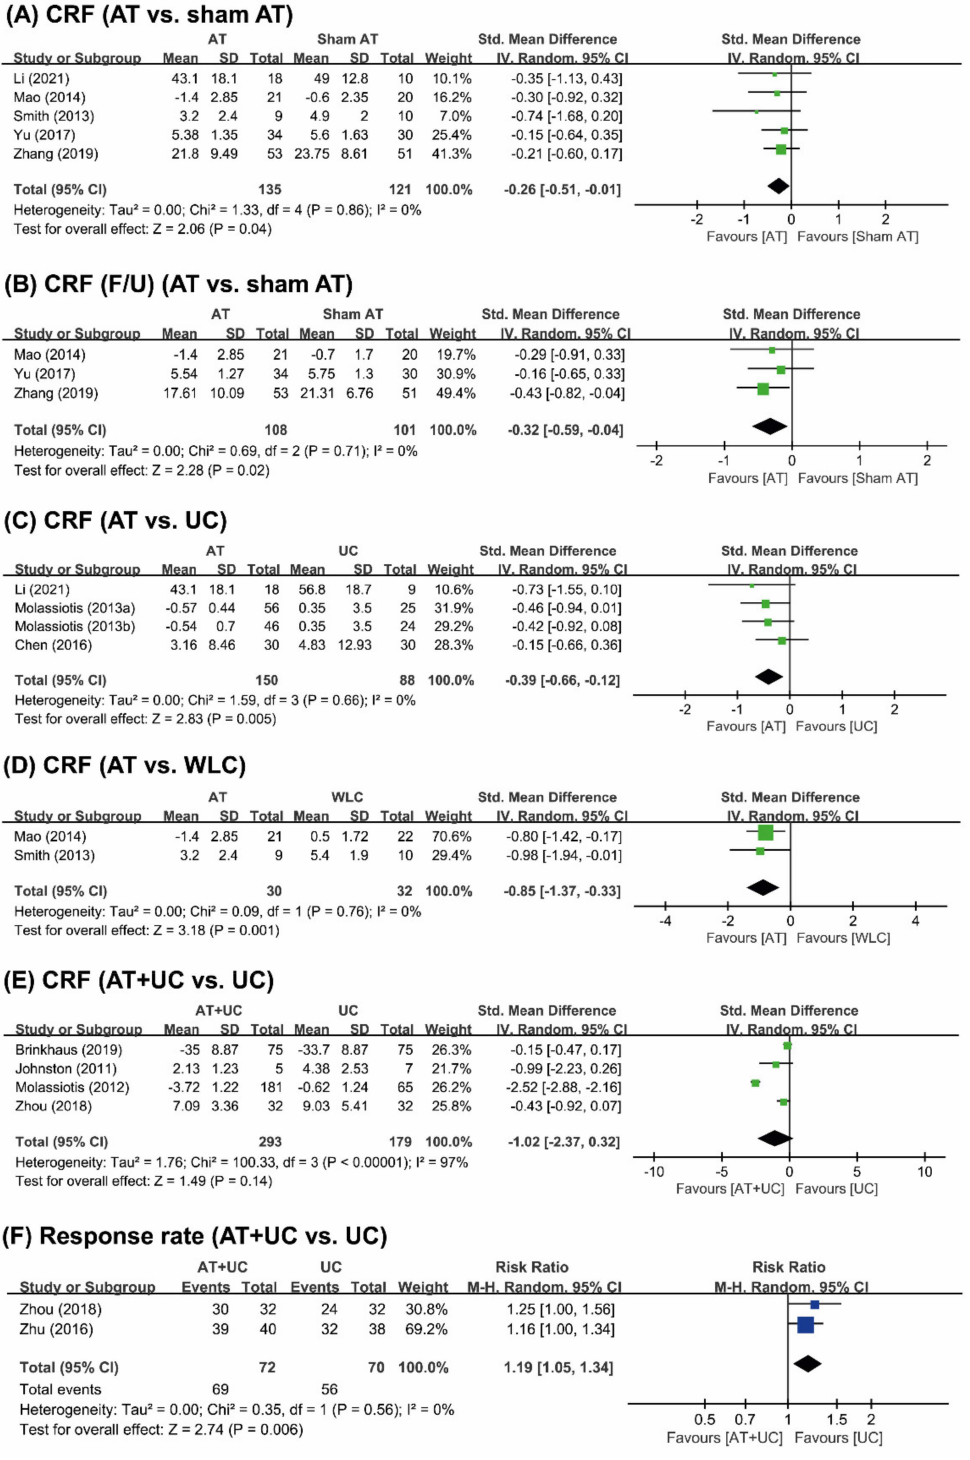
Figure 3. Forest plot of ( A ) AT vs. sham AT for CRF and ( B ) CRF of F/U; ( C ) AT vs. UC vs. UC for CRF; ( D ) AT vs. WLC for CRF; ( E ) AT+UC vs. UC for CRF; and ( F ) effective rate. AT: acupuncture; CRF: cancer-related fatigue; F/U: follow-up; UC: usual care; WLC: wait-list